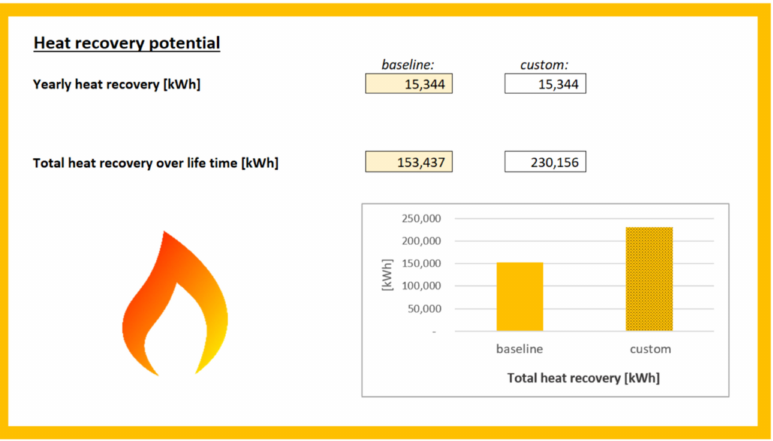
Figure 2. Example for results of the heat recovery potential from the toolkit. Assumptions: water